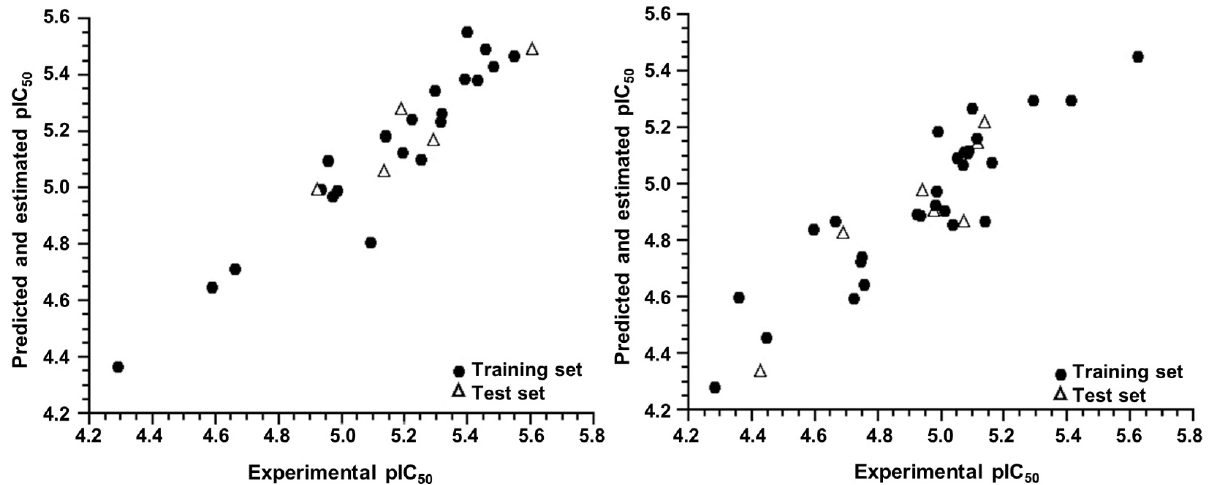
Table 3. Statistically significant models generated by AutoQSAR for the G 2 group.